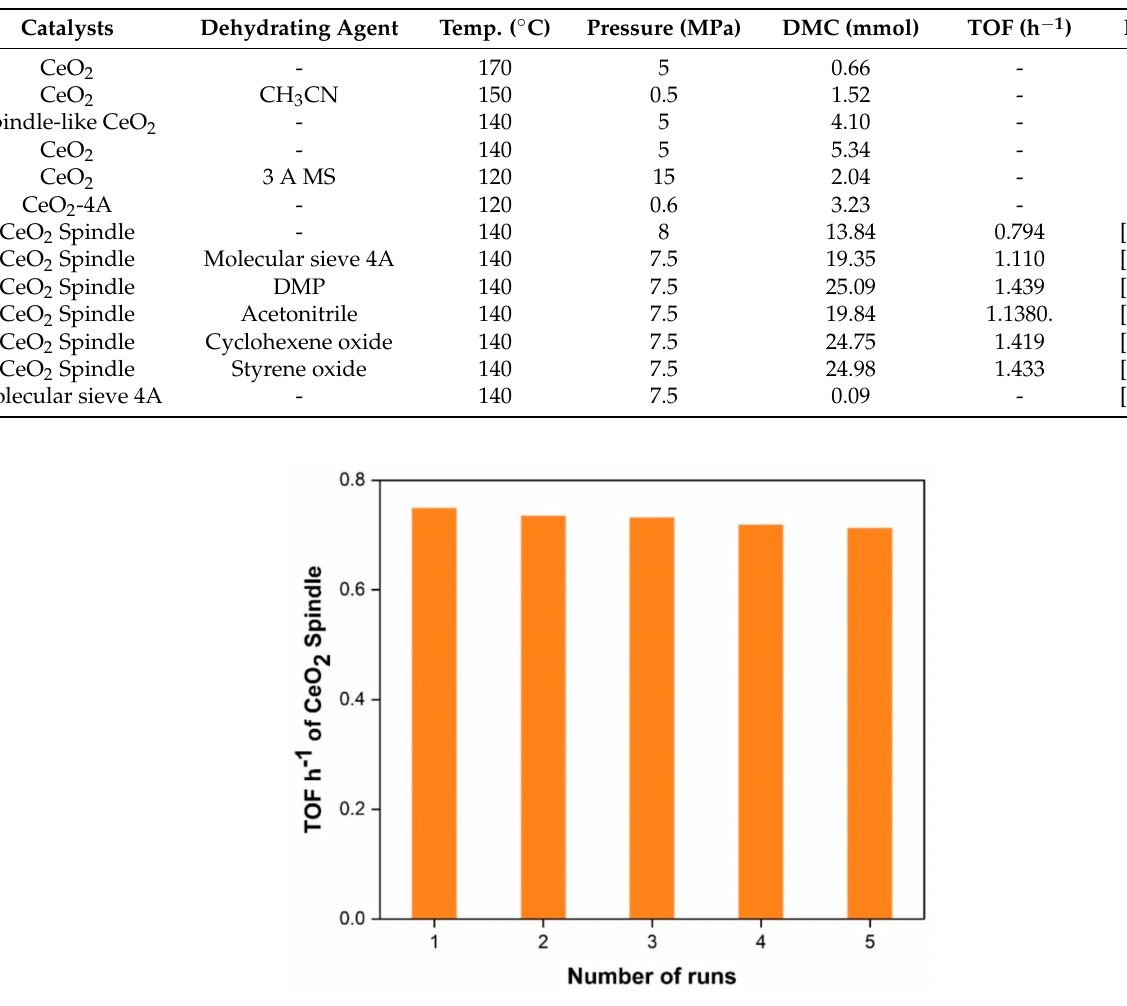
Figure 6. Reusability testing of spindle-shape CeO 2 for five consecutive